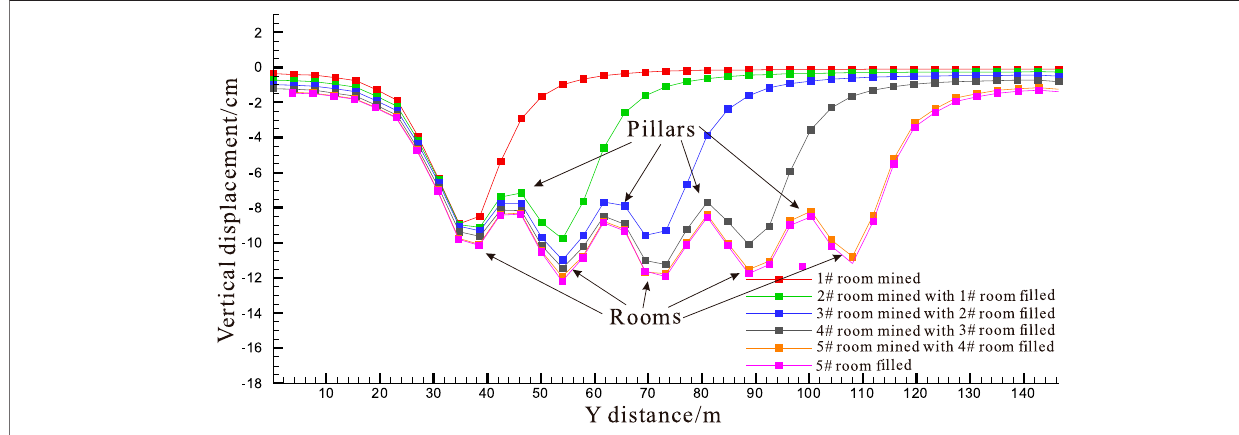
FIGURE 8 | Vertical displacement curves of the roof during back fi ll mining.